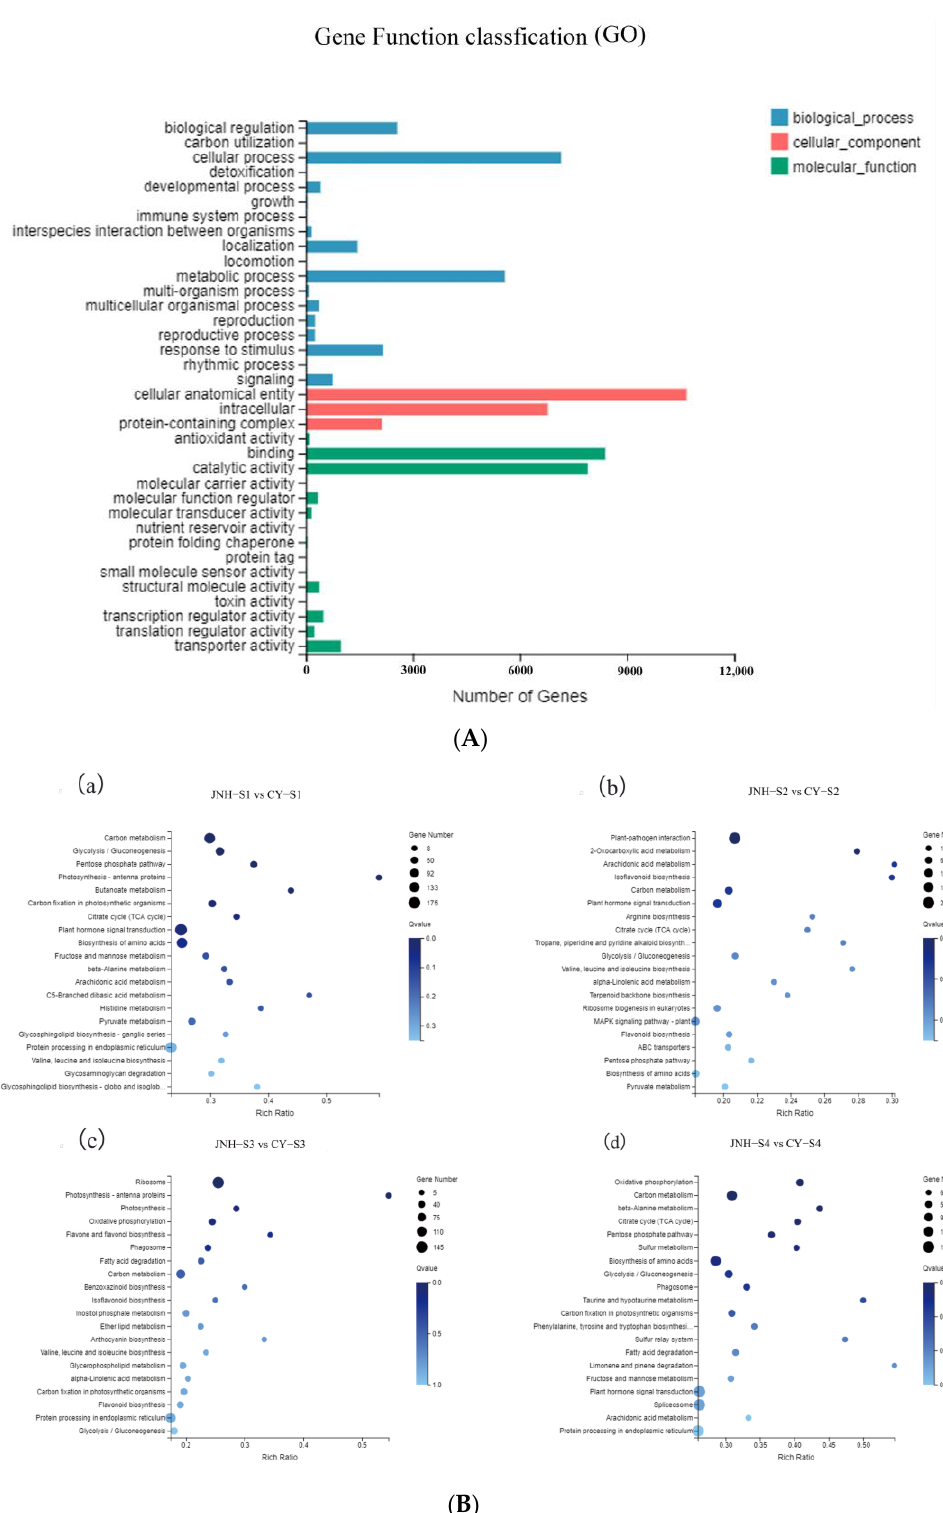
Figure 1. GO classification of unigenes ( A ) and DEGs-enriched KEGG pathway scatter plot ( B ) of red and yellow fruits of sweet cherry in four ripening stages. Pathway names are listed along the vertical axis, and the horizontal axis represents enriched factors that correspond to the pathway. ( a ) is the S1 period, ( b ) is the S2 period, ( c ) is the S3 period, ( d ) is the S4 period